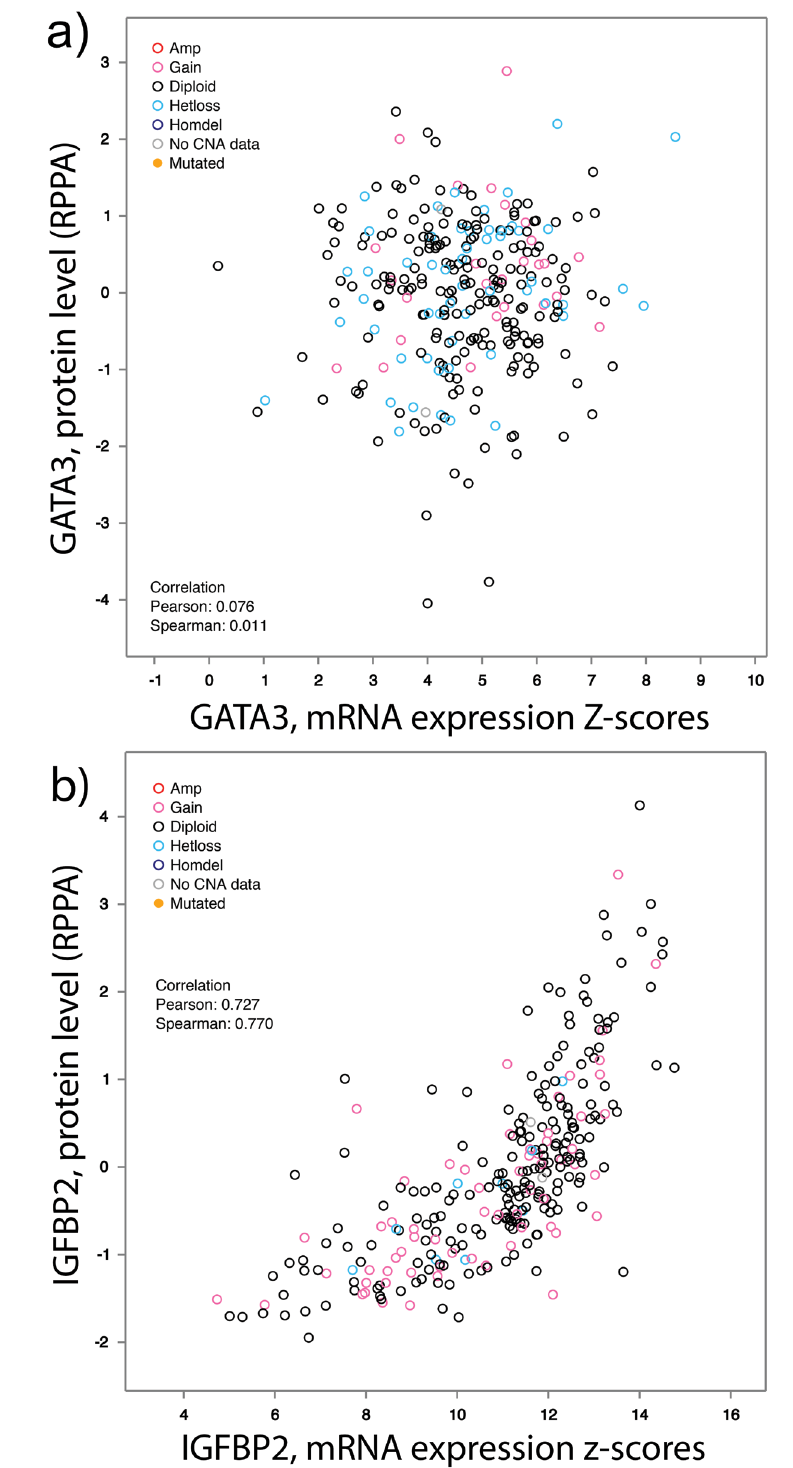
Supplemental Figure 4. Correlations of RPPA protein expression with RNA expression. GATA3 and IGFBP2 RPPA and mRNA expression values from TCGA datasets were plotted and analyzed on an individual tumor basis. ( a ) GATA3 mRNA expression does not correlate with protein expression. ( b ) IGFBP2 mRNA expression does correlate with protein expression. Plots were created with cBioPortal using TCGA (2012) dataset 6